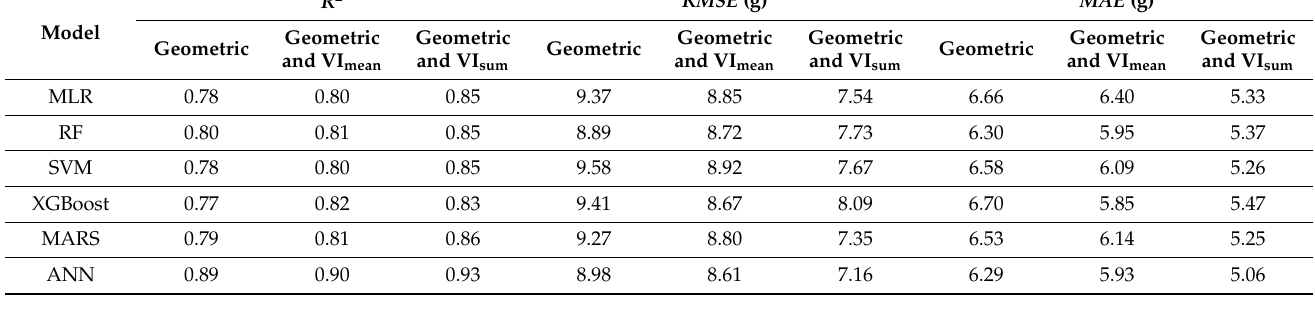
Table 4. Average five-fold CV results for the dry biomass models.